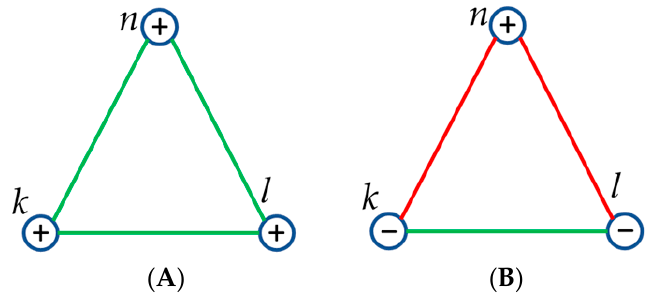
Figure 3. Logical interrelations between the points representing positive and negative curvatures are shown. Green edges connect the points placed on the segments where the curvatures are of the same sign; red edges connect the points placed on segments where the curvatures are differently signed. ( A ) Points in which the curvature is positive are placed in the vertices of the graph. Only green edges appear in the graph. ( B ) Points in which the curvature is positive and negative are placed in the vertices of the graph. The monochromatic triangle is impossible in this case.